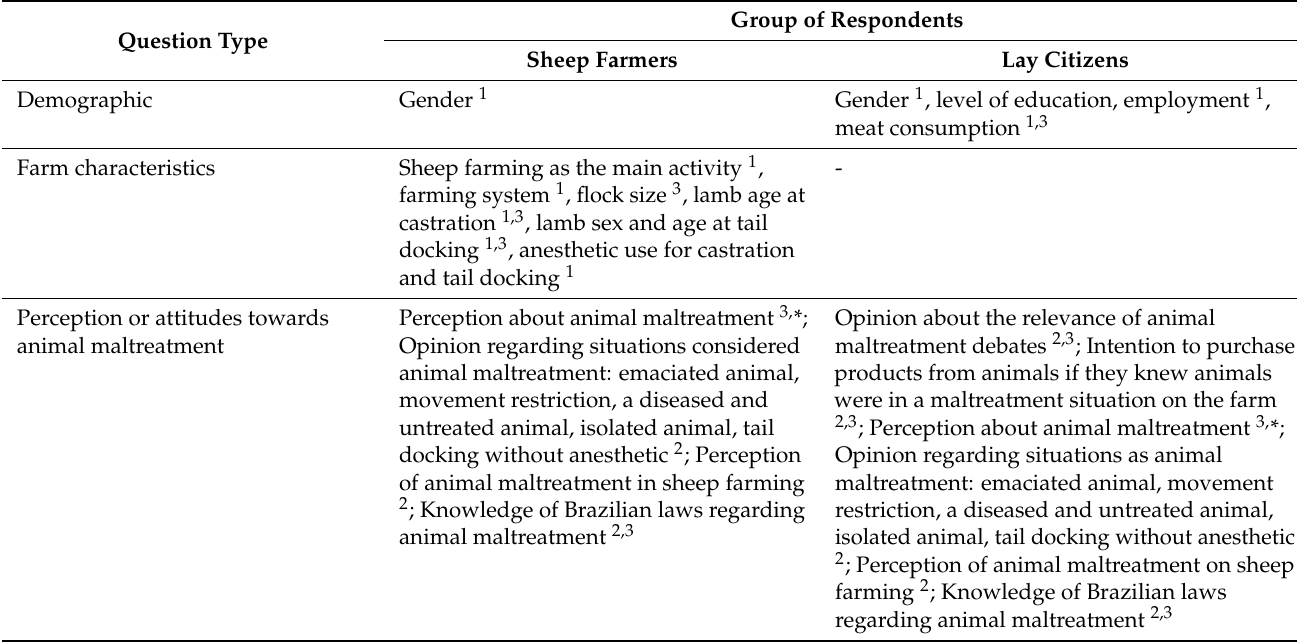
Table 1. Topics surveyed in a questionnaire for sheep farmers and lay citizens about sheep farming and animal maltreatment in Rio Grande do Sul, Brazil, from September 2017 to December